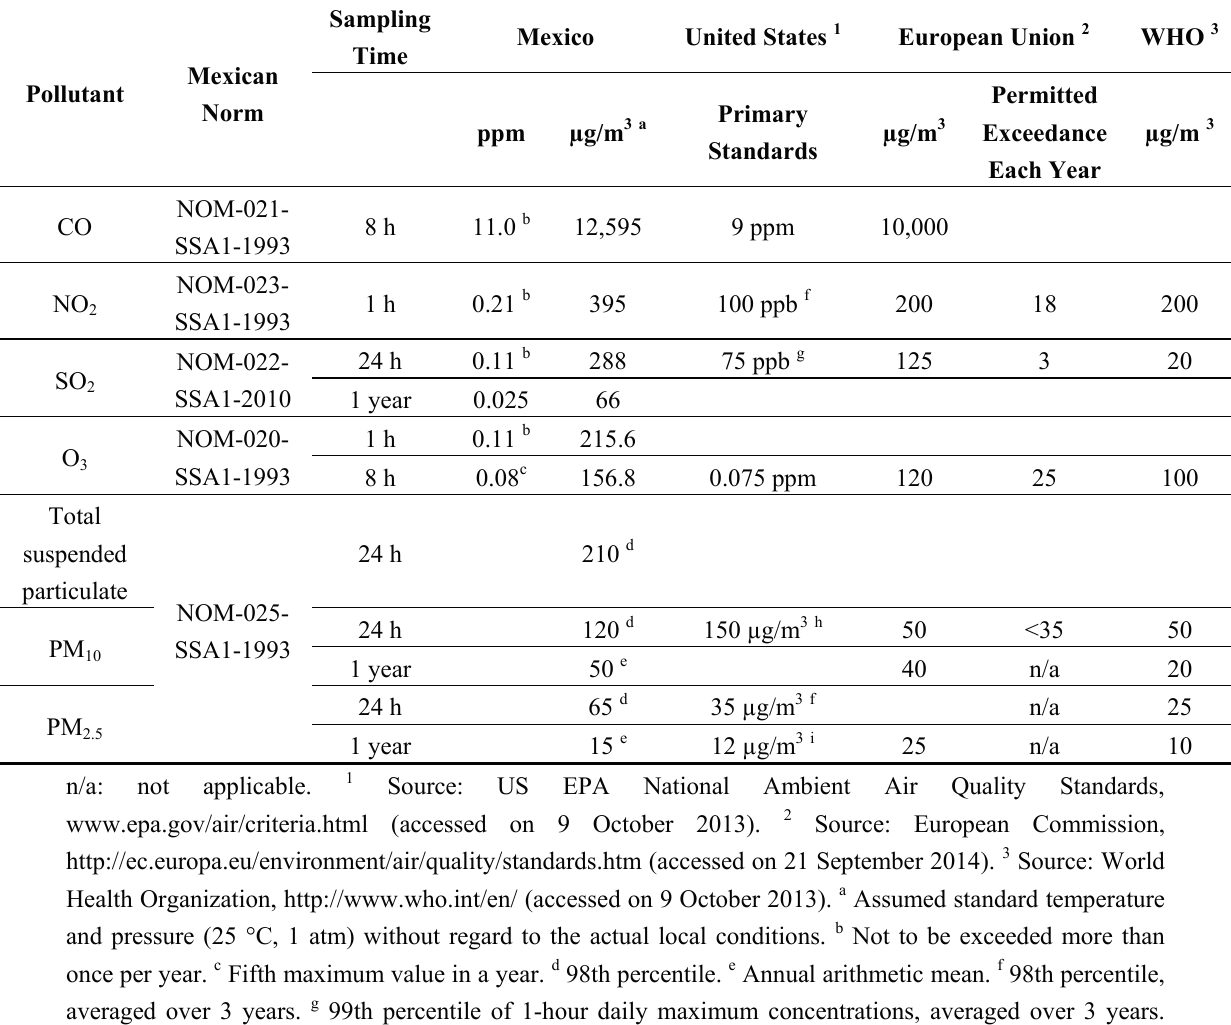
Table 2. Comparison of air quality standards (MPL) in Mexico, the US, the EU, and the World Health Organization